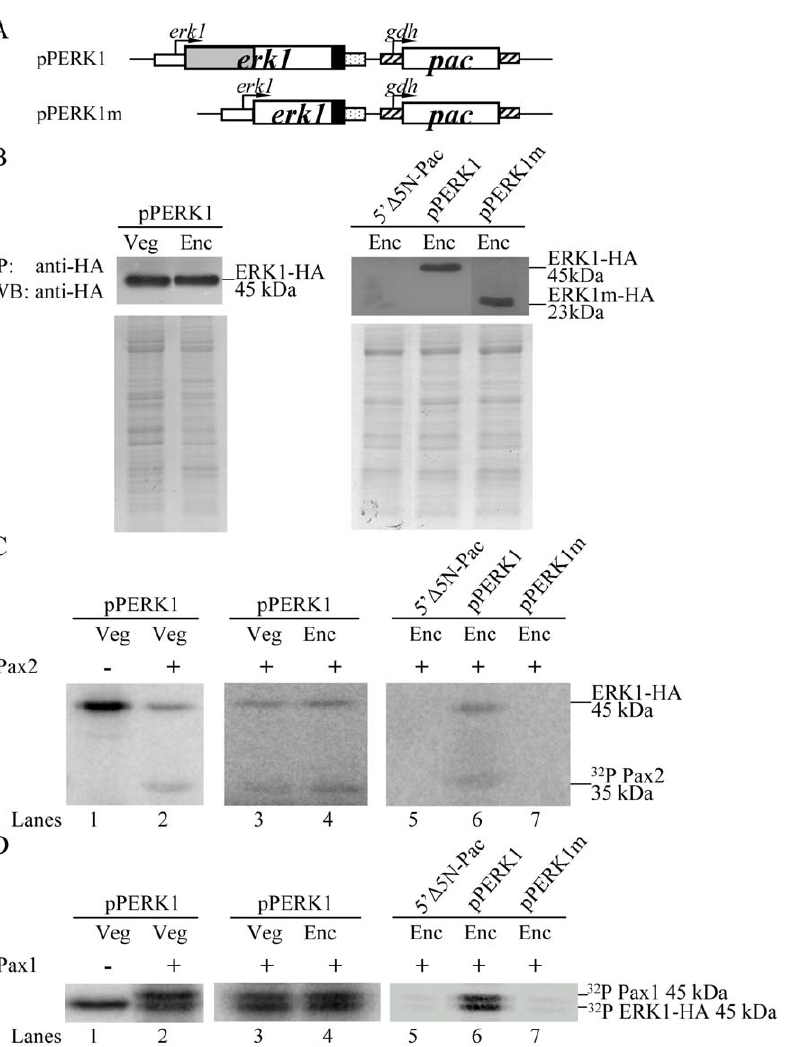
Figure 10. Phosphorylation of Pax2 and Pax1 proteins by ERK1 associated complexes. (A) Diagrams of the pPERK1 and pPERK1m plasmids. The pac gene (open box) expression cassette is the same as in Figure 2C. The erk1 gene is under the control of its own 5 9 -flanking region (open boxes) and the 3 9 -flanking region of the ran gene (dotted box). ERK1m does not contain the predicted kinase domain (residues 26–202)(gray box). The filled box indicates the coding sequence of the HA epitope tag. (B) Similar levels of immunoprecipitated ERK1 protein from the